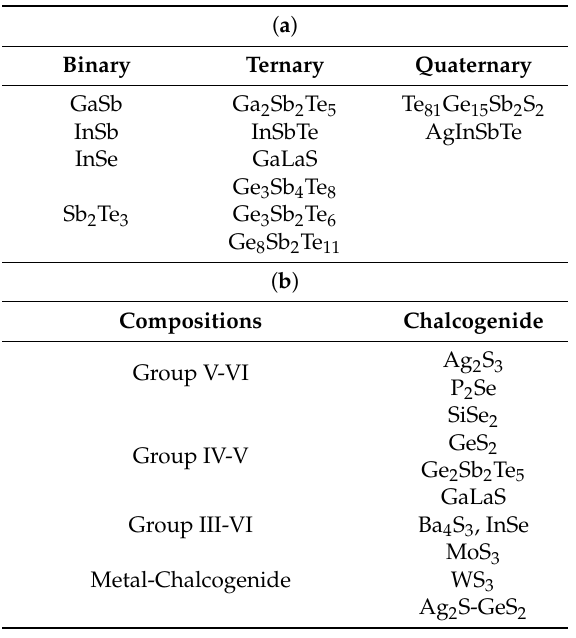
Table 2. Classification of chalcogenides with their ( a ) various compounds and ( b ) different elemental